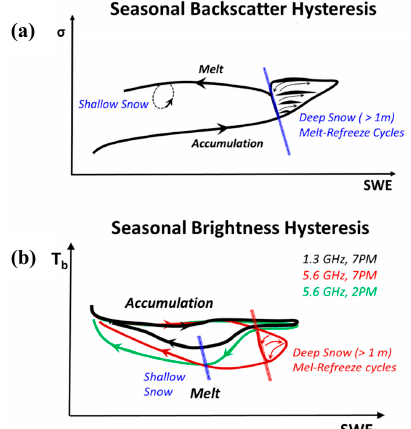
Figure 17. Conceptual synthesis of microwave hysteresis: ( a ) Synthesis of seasonal snowpack backscatter behavior as a function of SWE exhibiting hysteresis between accumulation and melt phases at L- and C-band (e.g., 1.3 and 5.6 GHz). Hysteresis is not present at Ku-band (e.g., 13.5 GHz) and higher frequencies; ( b ) synthesis of seasonal brightness behavior as a function of SWE exhibiting hysteresis between accumulation and melt phases at L- and C-bands.